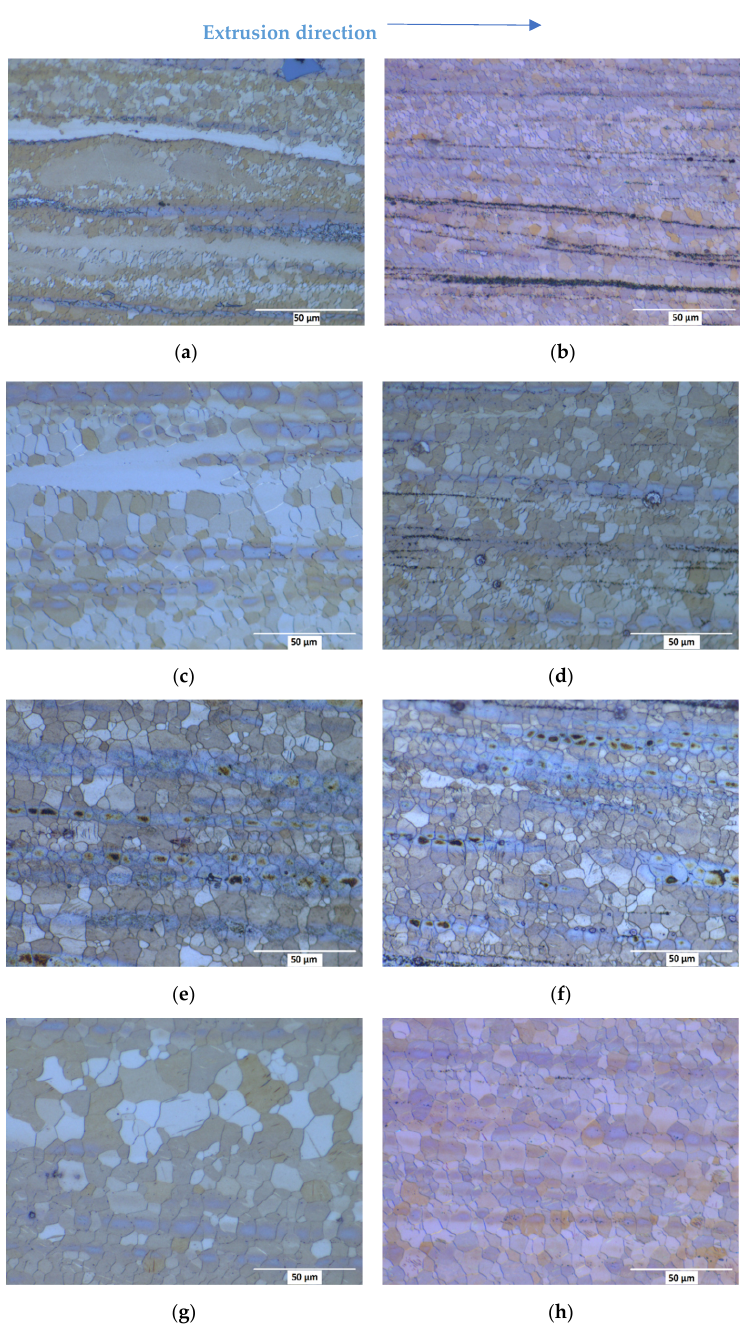
Figure 2. Optical micrographs from longitudinal sections of extruded round bars of AM60 ( a , c , e , g ) and AM60 with 1 wt.% AlN ( b , d , f , h ) with different extrusion speeds: 0.6 ( a , b ), 4.4 ( c , d ), 6.6 ( e , f ) and 8.0 mm/s ( g , h ).